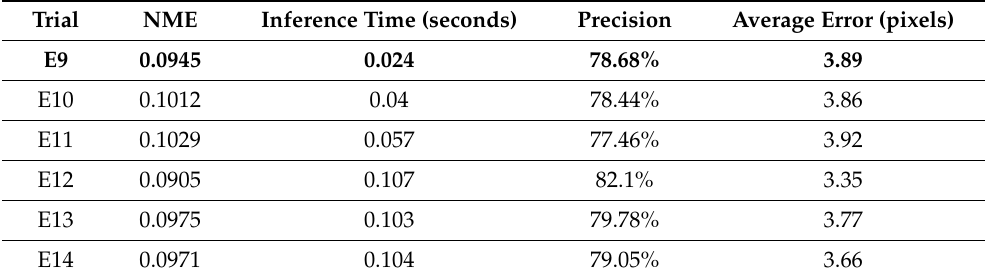
Table 14. Results obtained for each trial performed in human caruncle detection task. Bold lines represent best selected results for each